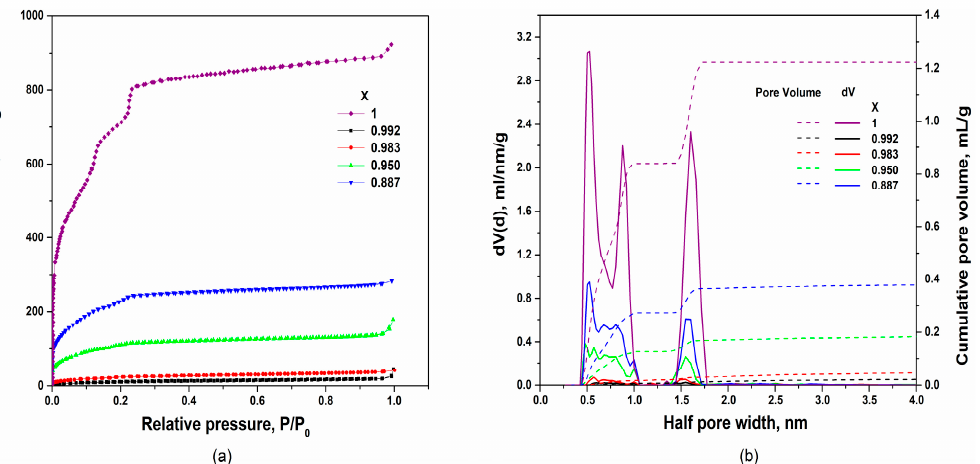
Figure 3. Nitrogen adsorption-desorption isotherms obtained at 77 K ( a ) and calculated DFT pore size distributions (solid lines) and cumulative pore volumes (dashed lines) for (1-x)LiClO 4 –xMIL-101(Cr) composites ( b ). Table 1. The porous structure parameters of LiClO 4 -MIL-101(Cr) composites. Composition